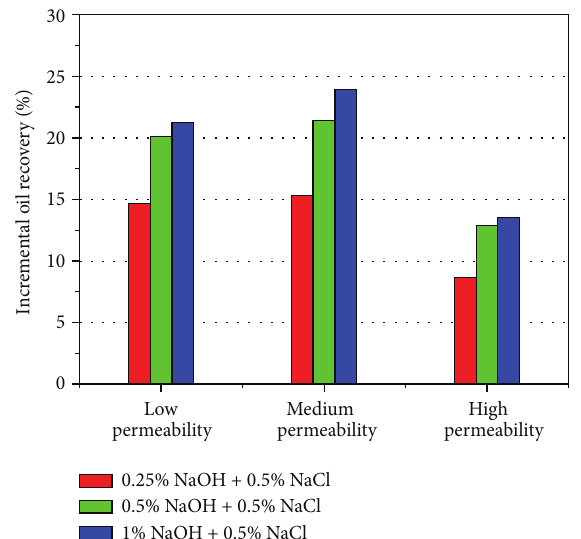
viscosity, the tertiary oil recovery was as high as 20% at both low- and medium-permeabilities, but it also decreased when the permeability was approximately 2000 mD. These results demonstrate that oil with a higher viscosity exhibits a wider range of applicable permeability and that only in the low- permeability sandpacks can the low-viscosity heavy oil such as Zhuangxi oil achieve a high tertiary oil recovery.